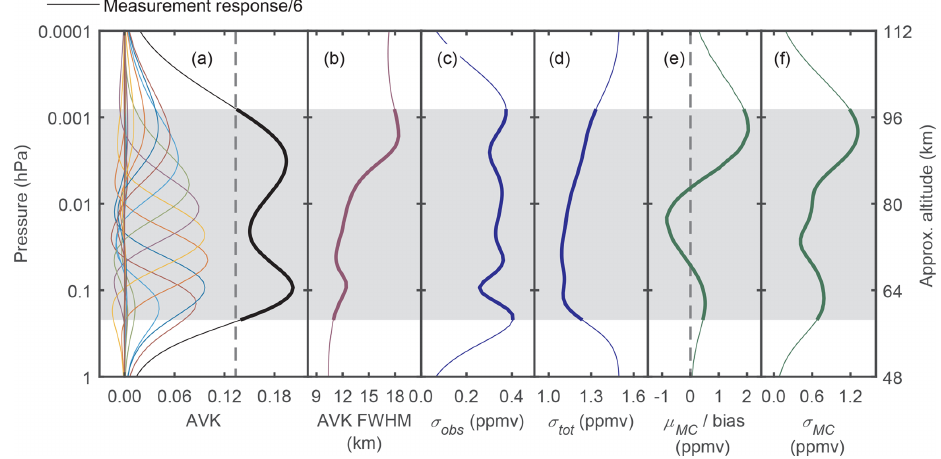
Figure 9. Ozone (O 3 ) retrieval diagnostics for simulated 6h observations of the O 3 11.072GHz emission line using a ground-based ra- diometer with 1mK baseline noise level, 10kHz frequency resolution, and an 82 ◦ zenith angle located at Kilpisjärvi (69 ◦ 03 (cid:48) N, 20 ◦ 48 (cid:48) E), Finland, in clear-sky December conditions. In (a) every sixth averaging kernel and the scaled measurement response (MR) are shown. Panel (b) shows the full-width half maxima of each averaging kernel (AVK FWHM). The measurement uncertainty ( σ obs ) and total uncer- tainty ( σ tot ) are shown in (c) and (d) respectively. The mean ( µ MC ) and standard deviation ( σ MC ) of the differences between the retrieved and true profiles from Monte Carlo (MC) error analysis using 500 repeat inversions are shown in (e) and (f) respectively. The vertical grey dashed line in (a) shows the cut-off for MR ≥ 0.8. The grey shaded regions and the thicker sections of the plotted curves indicate the pressure and altitude ranges where MR ≥ 0.8.